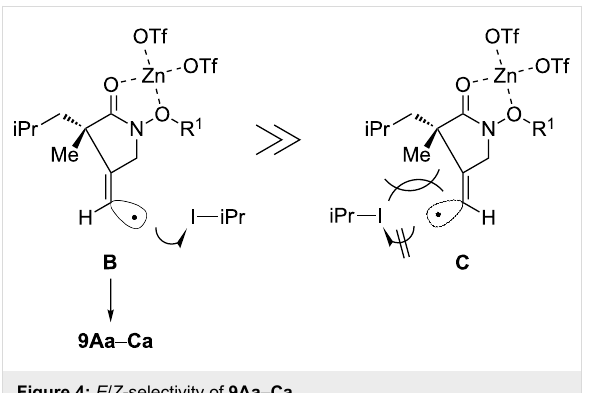
Figure 4: E / Z -selectivity of 9Aa – Ca